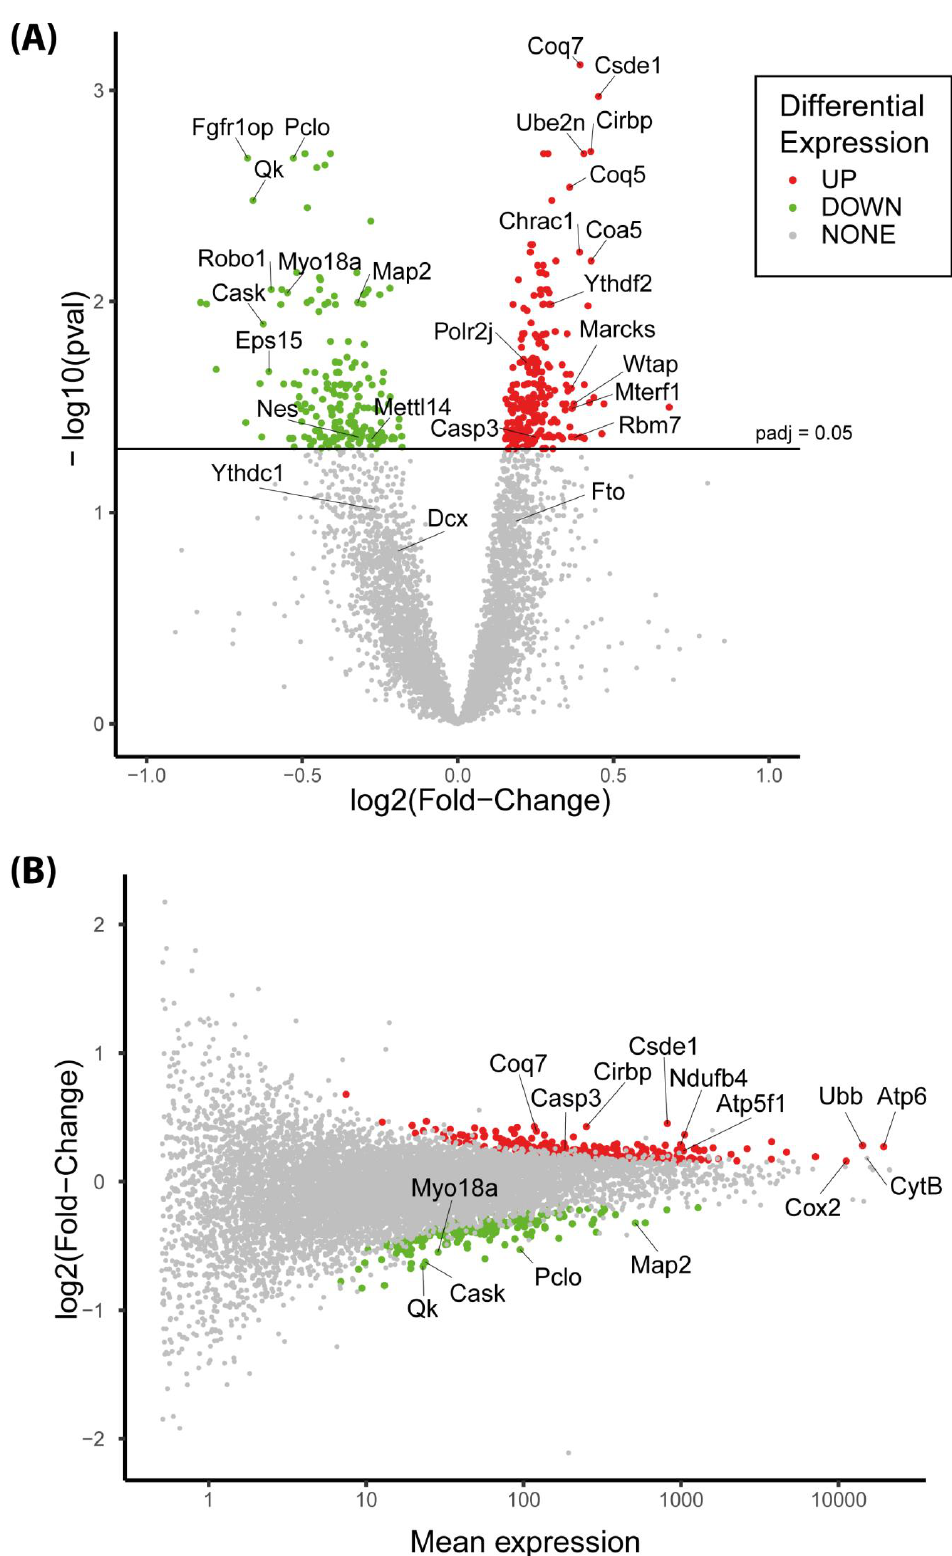
Figure 3. Volcano plot ( A ) and MA plot ( B ) of differentially expressed genes at E17 in the protein restriction (PR) group compared to Control group (PR: n = eight males + eight females, C: n = eight males + eight females). (padj = adjusted p -value from Deseq2 analysis). Mean expression corresponds to the average normalized read number.